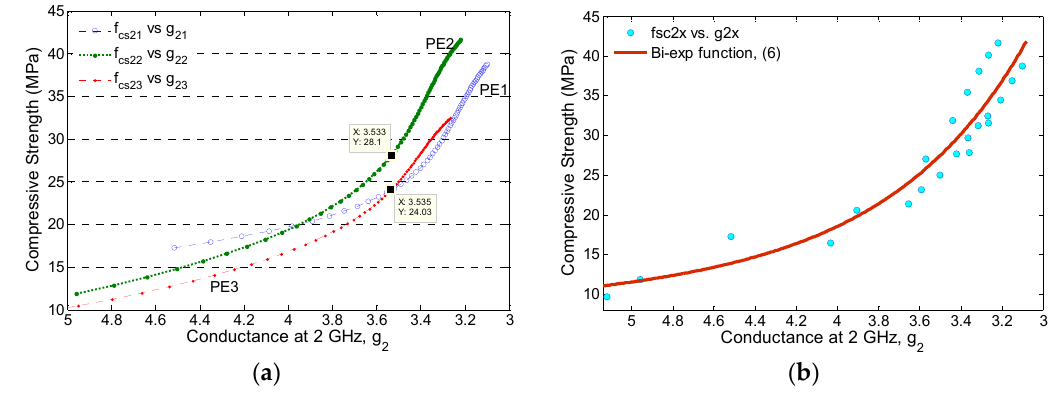
Figure 12. ( a ) Computed correlations between compressive strength and conductance directly using regression functions (4) and (5); ( b ) proposed regression function (6) for fitting of all S ‐ C dat a.